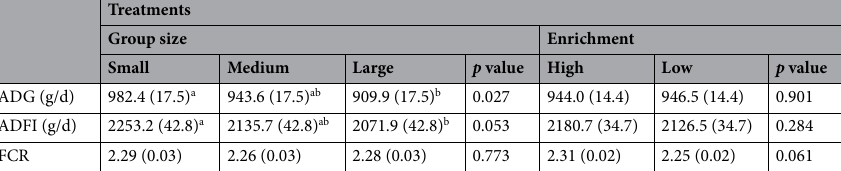
Animal performance. Table 4 summarizes the effect of group size and enrichment on animal performance.